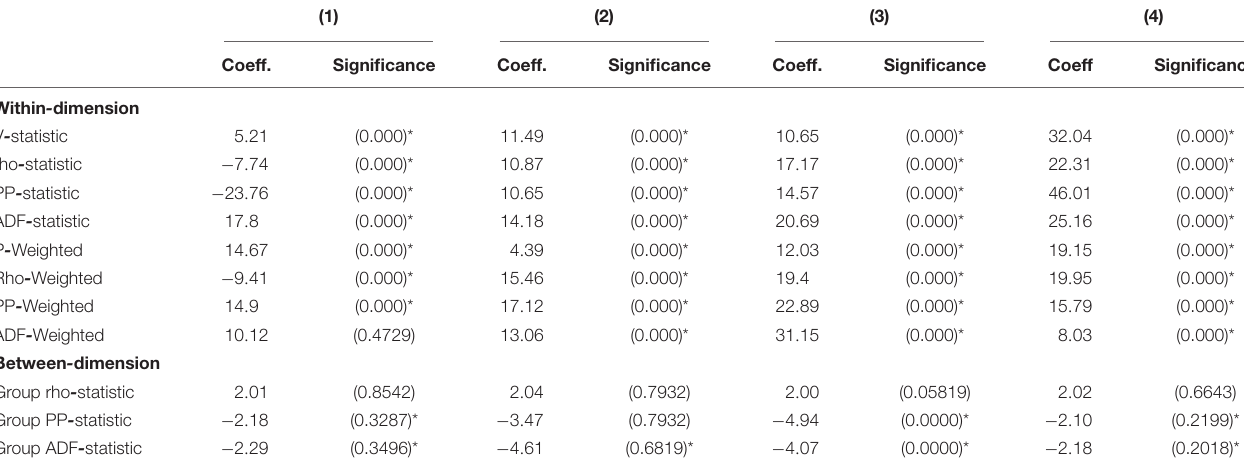
TABLE 5 | Co-integration results.